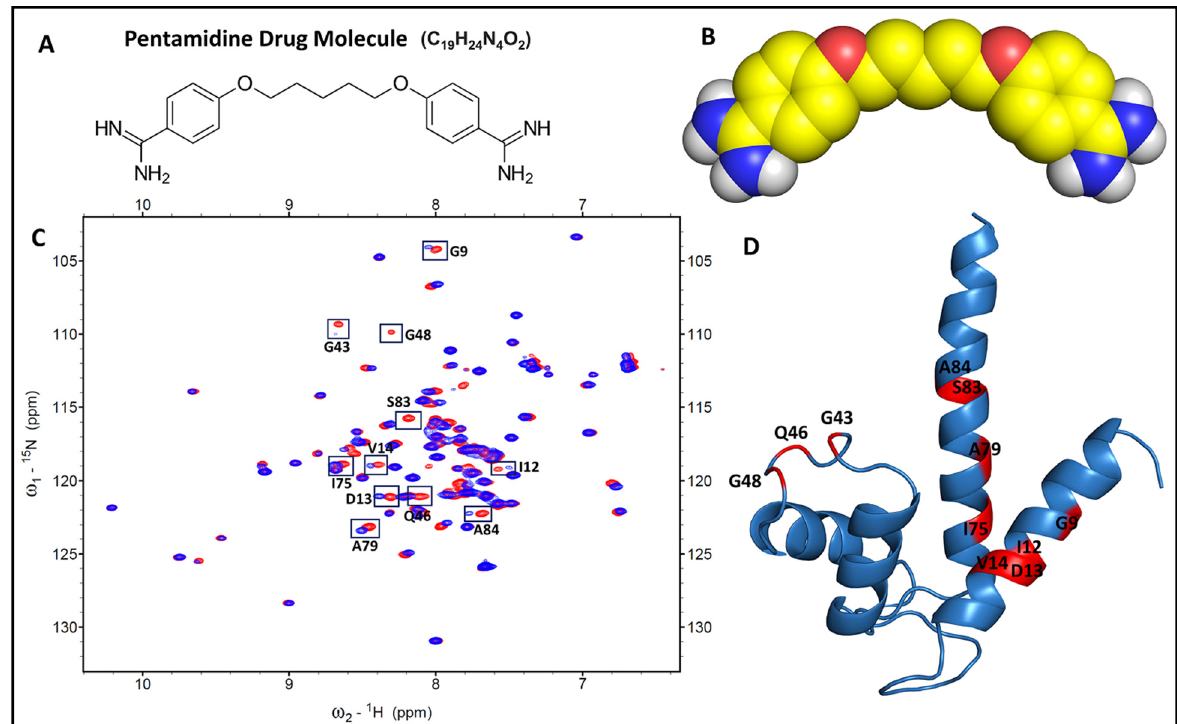
Figure 4. Analysis of the free S100P and S100P–pentamidine complex using 2D NMR at a 1:1 binding ratio. ( A ) The structural formula of pentamidine. ( B ) Sphere structure presentation of pentamidine. ( C ) The overlaid 2D [ 1 H- 15 N]-HSQC spectra highlight the spectral changes (showed in boxes) of the uniformly 15 N-labeled S100P alone (shown in red) and 15 N-labeled S100P upon binding to unlabeled pentamidine molecules (shown in blue). ( D ) These selected cross-peak residues (boxed in Figure 4C) were colored in red and unbound residues were colored in blue on the cartoon structure of S100P using the PyMOL program.